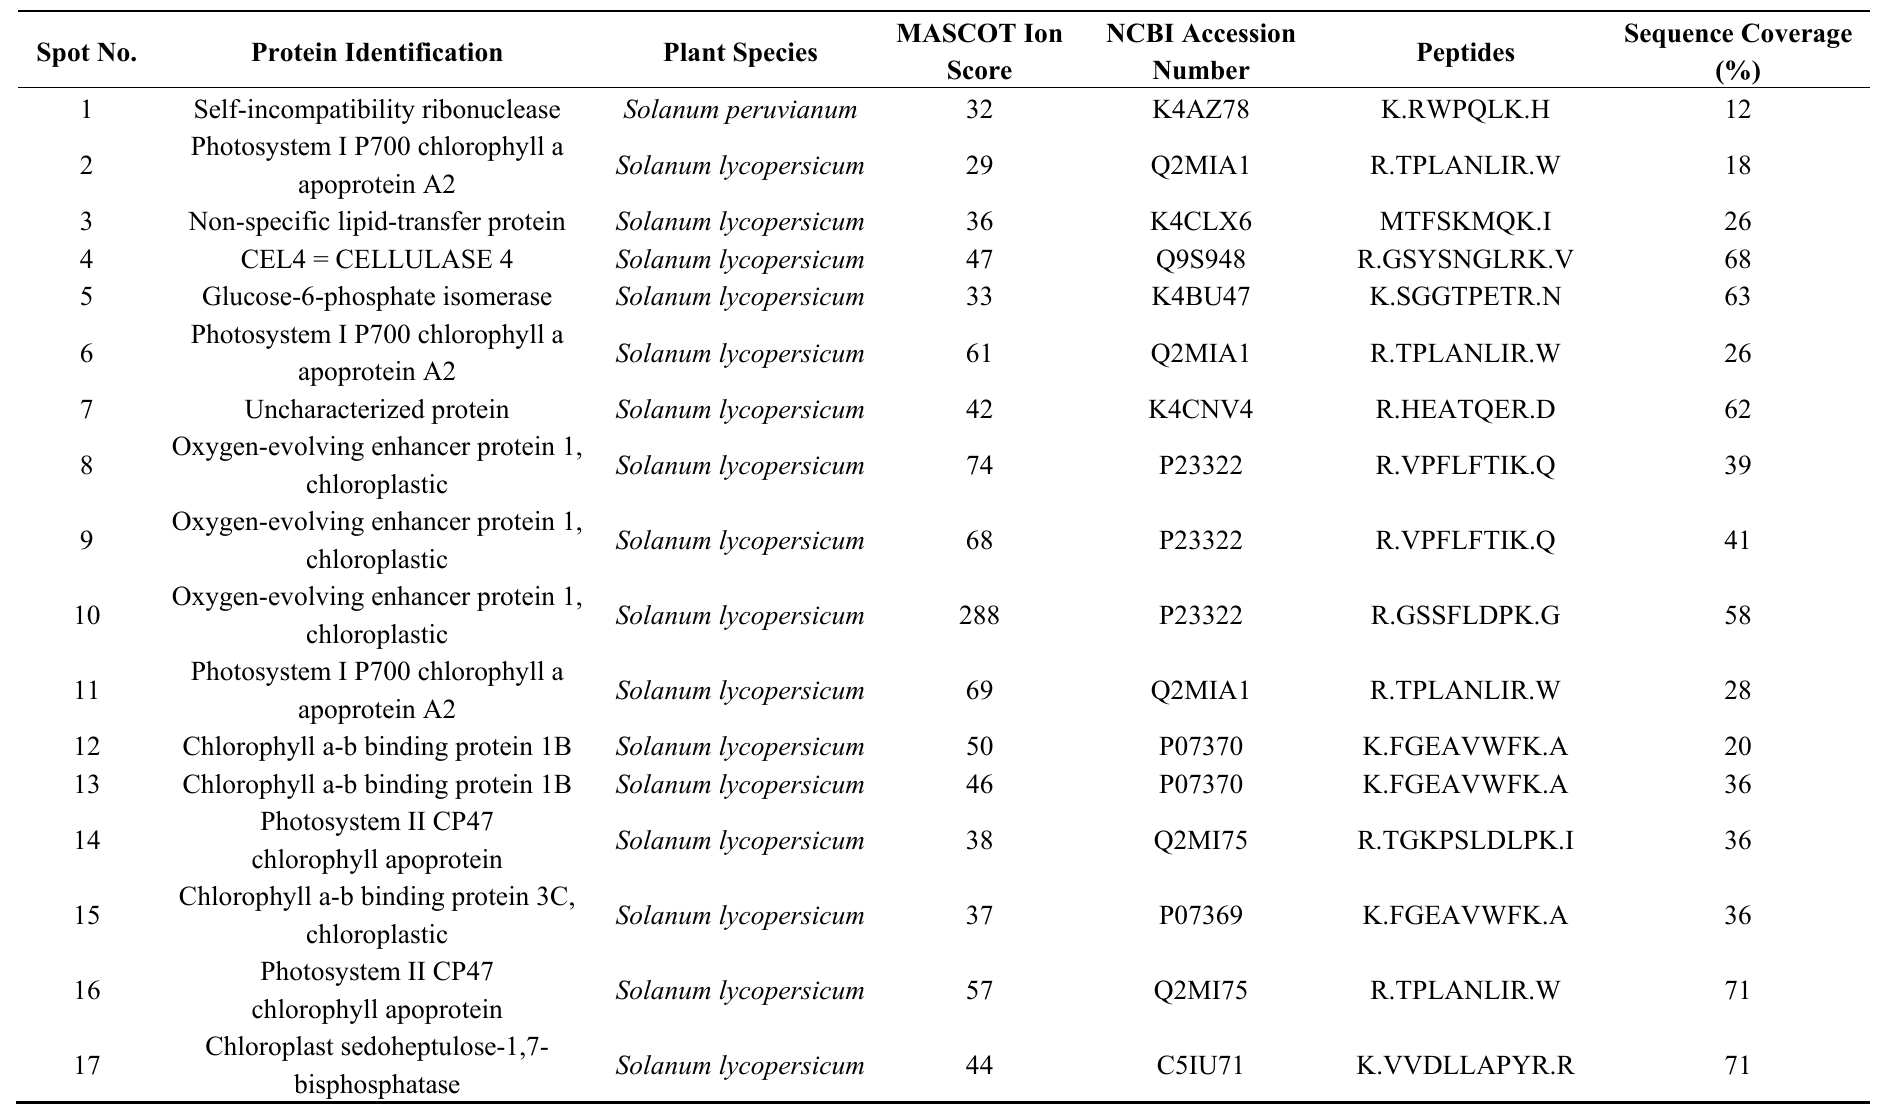
Table 1. Proteins identified in 2D-BN-SDS-PAGE map of tomato